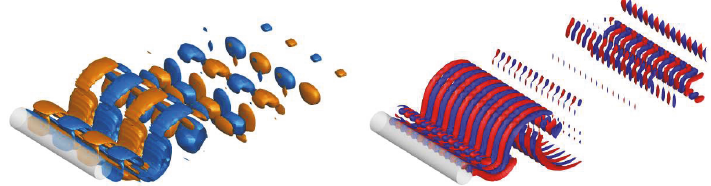
Figure 10: Streamwise velocity contours for modes A (left) and B (right) obtained at Re = 280 , with and 𝐿 𝑧 = 6.99 .